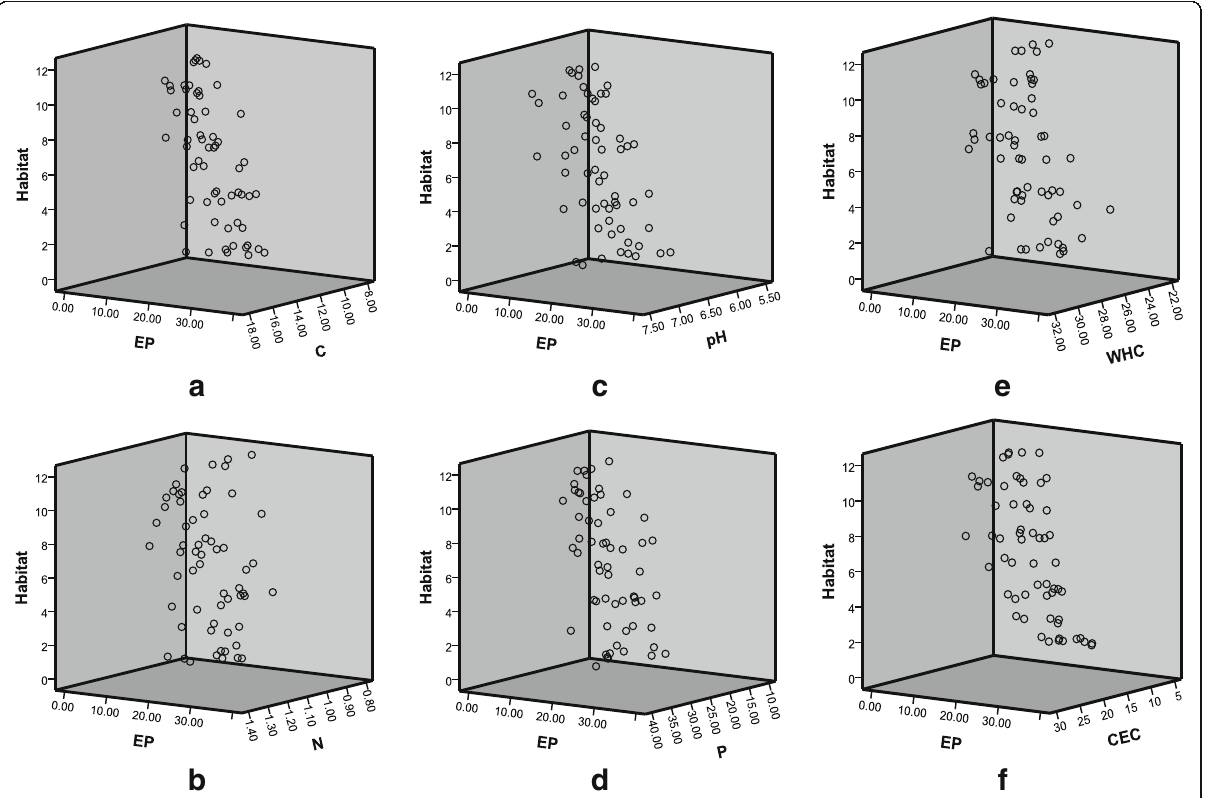
Fig. 1 a 3D scatter plot of earthworm population with organic carbon across various habitats. b 3D scatter plot of earthworm population with total nitrogen across various habitats. c 3D scatter plot of earthworm population with pH across various habitats. d 3D scatter plot of earthworm population with available phosphorus across various habitats. e 3D scatter plot of earthworm population with water holding capacity across various habitats. f 3D scatter plot of earthworm population with cation exchange capacity across various